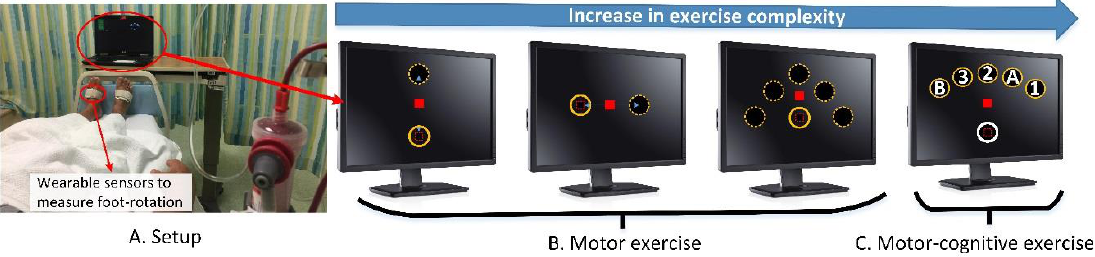
Figure 1. ( A ) A patient performing the intradialytic exergame during hemodialysis treatment in a regular dialysis clinic. Sensors attached on feet measure three-dimensional foot rotation. The measured foot rotation is transformed into movement of a cursor displayed on a laptop placing in front of the participant; ( B ) An illustration of the point-to-point foot rotation exercise. The participant is asked to rotate his/her foot to bring the laptop cursor (red square) into target circles as fast as possible. Exercise tasks require up to 30 degrees dorsiflexion (to move the cursor upward), plantarflexion (to move cursor downward), and medial/lateral rotation (to move the cursor to right/left). The exercise starts with simple complexity (up and down). Then the exercise complexity is gradually increased. ( C ) An illustration of the foot rotation and working memory exercise. For this exercise, in addition to the motor exercise (foot rotation), participants need to hit target circles with sequential orders